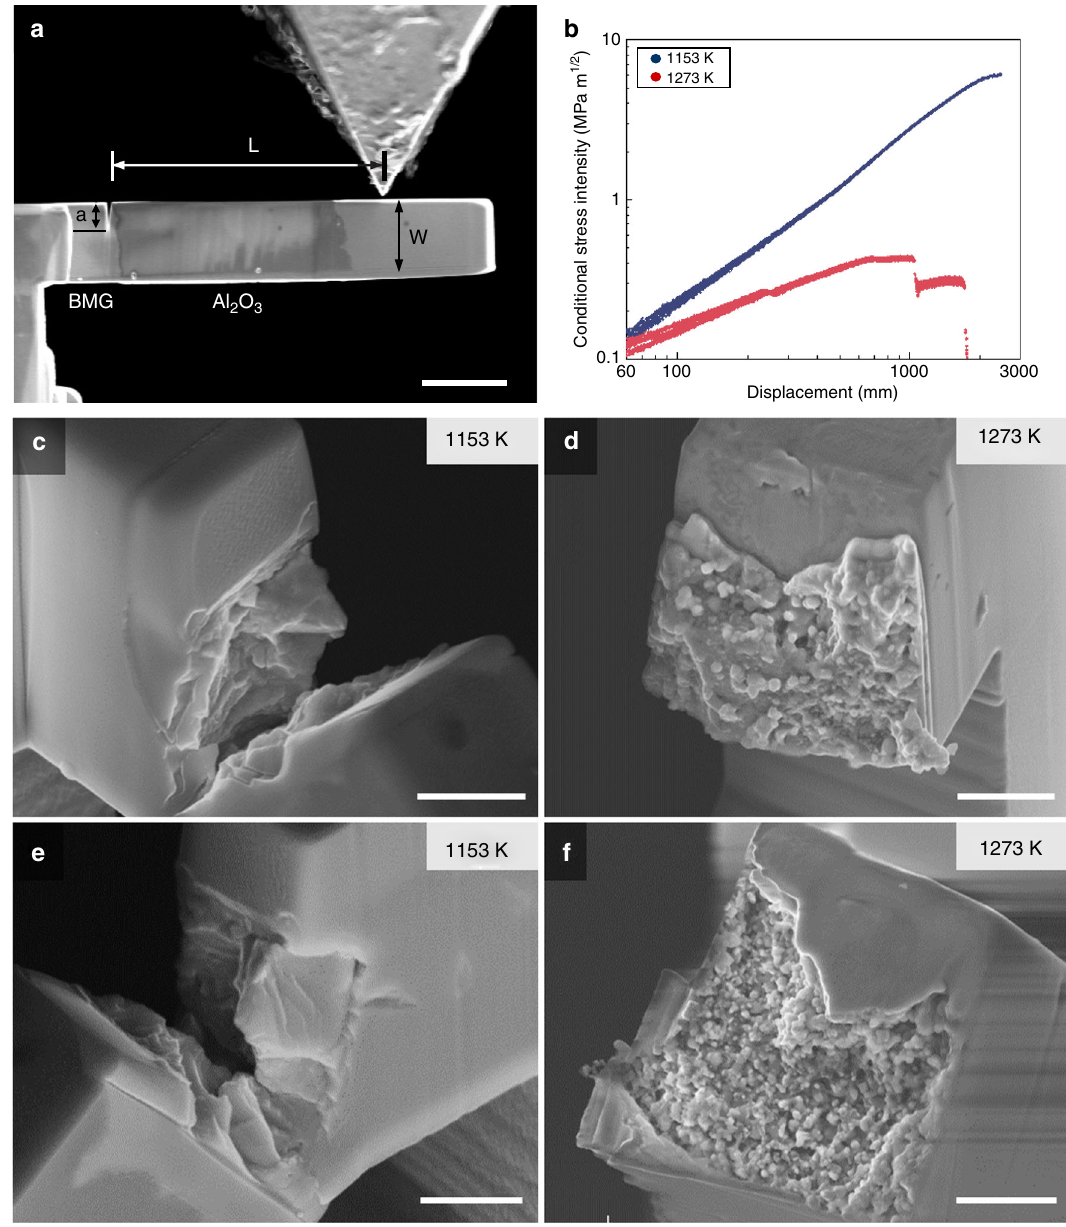
Fig. 9 SEM micrographs and results of micro-cantilever tests. a Representative micro-cantilever specimen for interface toughness measurement. b Conditional stress intensity – displacement curves for 1153 K (blue) and 1273 K (red) in fi ltrated specimens, respectively, on a log – log scale. c – f SEM micrographs of the fracture surfaces of the same 1153 K ( c , e ) and 1273 K ( d , f ) in fi ltrated specimens, showing a clear distinction between interfacial fracture ( d, f ) and fracture through the BMG phase ( c , e ). Scale bars: 5 μ m ( a ), 1 μ m ( c – f